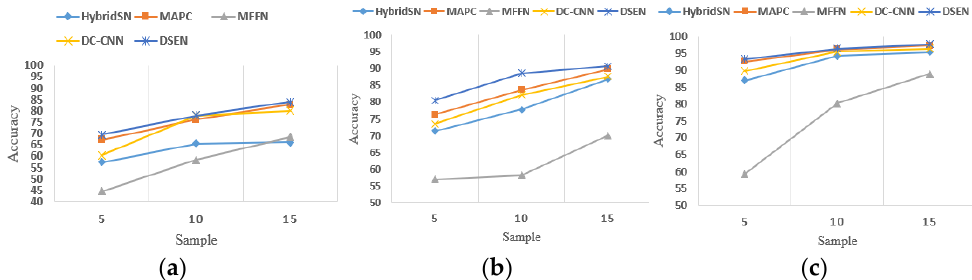
Figure 10. Classification accuracy for different datasets when the number of training samples is increased. ( a ) IP; ( b ) UP; ( c ) SA.